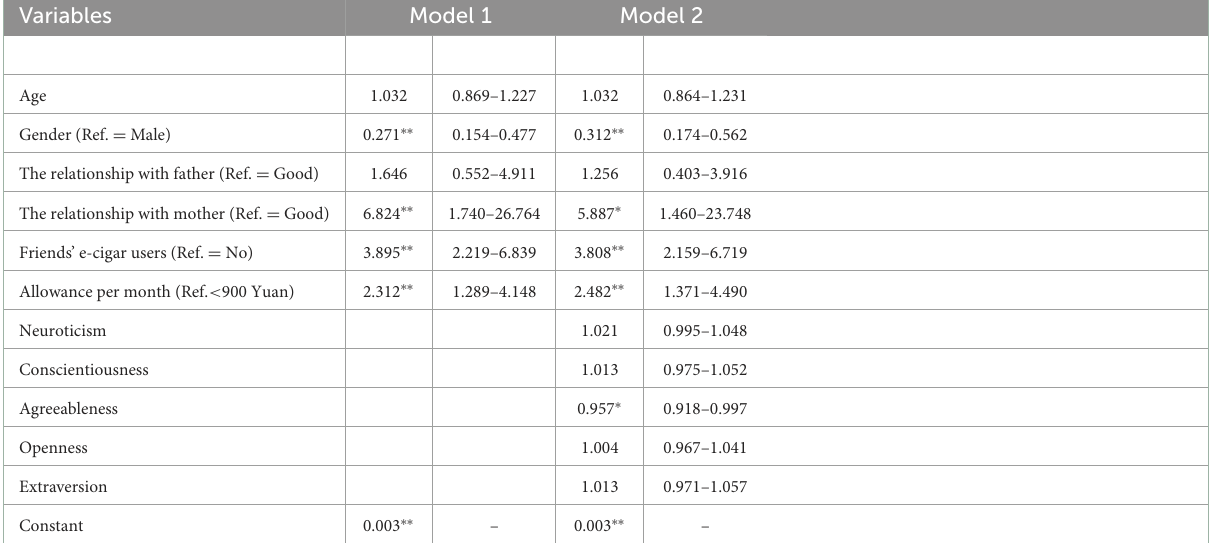
TABLE 4 Factors associated with the use of e-cigar among college